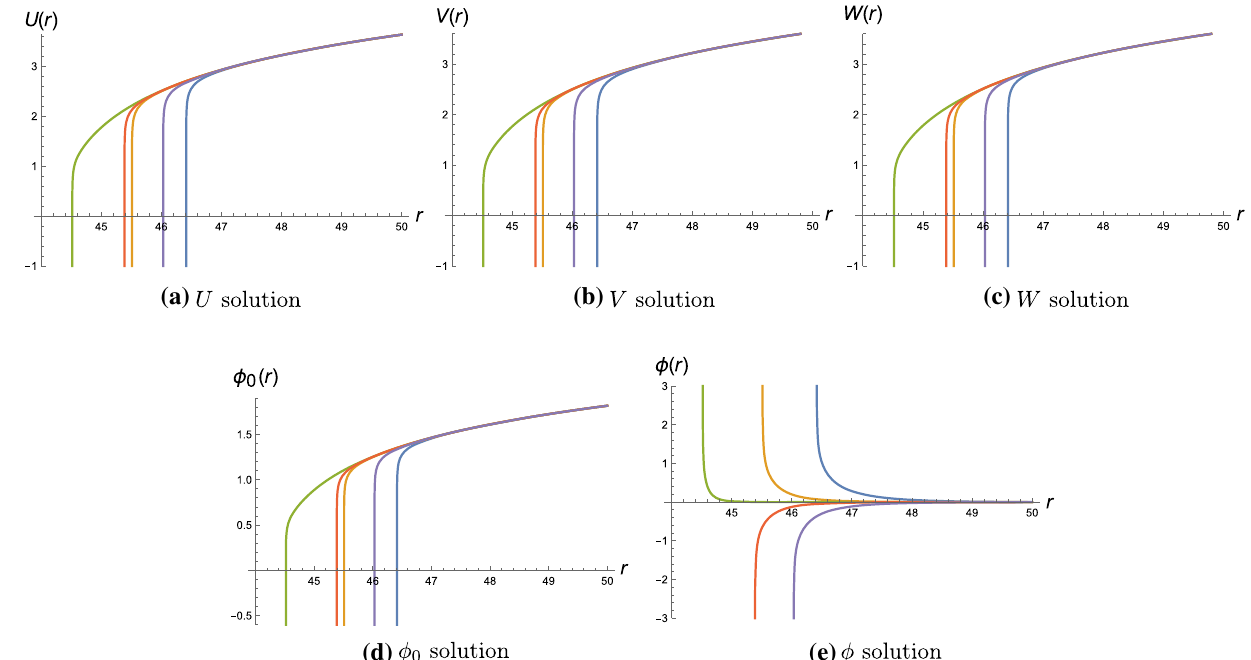
Fig. 40 Supersymmetric flows interpolating between asymptotically locally flat domain walls and Mk w 2 × S 2 × H 2 -sliced curved domain walls in SO ( 4 ) gauge group. The blue, orange, green, red and purple curves refer to p 21 = − 0 . 5 , − 0 . 03 , 0 , 0 . 08 , 0 . 25, respectively